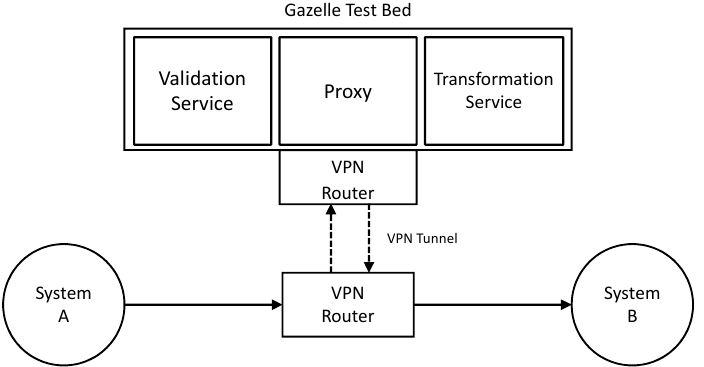
Figure 18. Schematic set-up for interoperability testing: directional communication is routed through the VPN connection to capture, transform and validate messages using the according Gazelle tools.